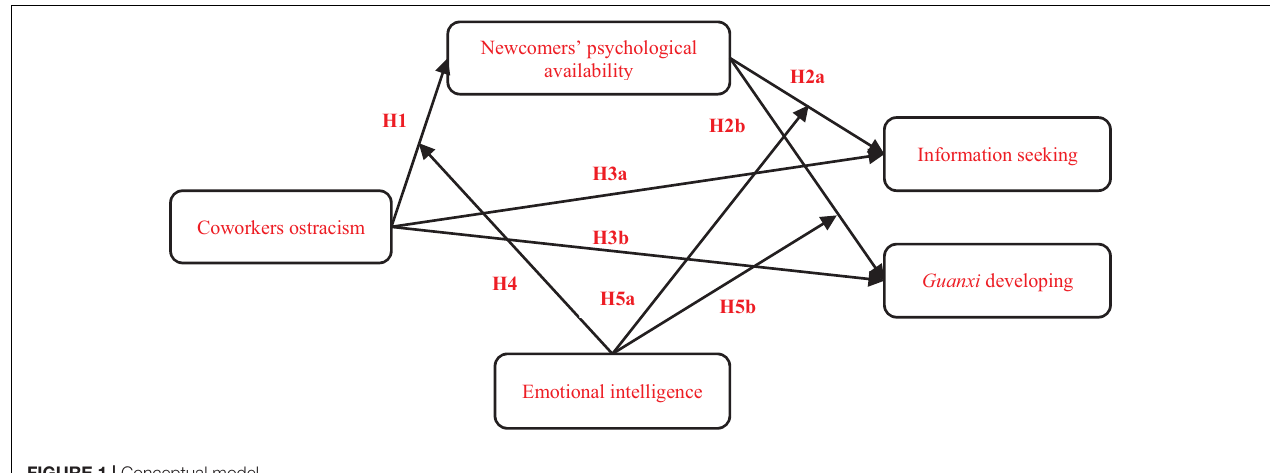
FIGURE 1 | Conceptual